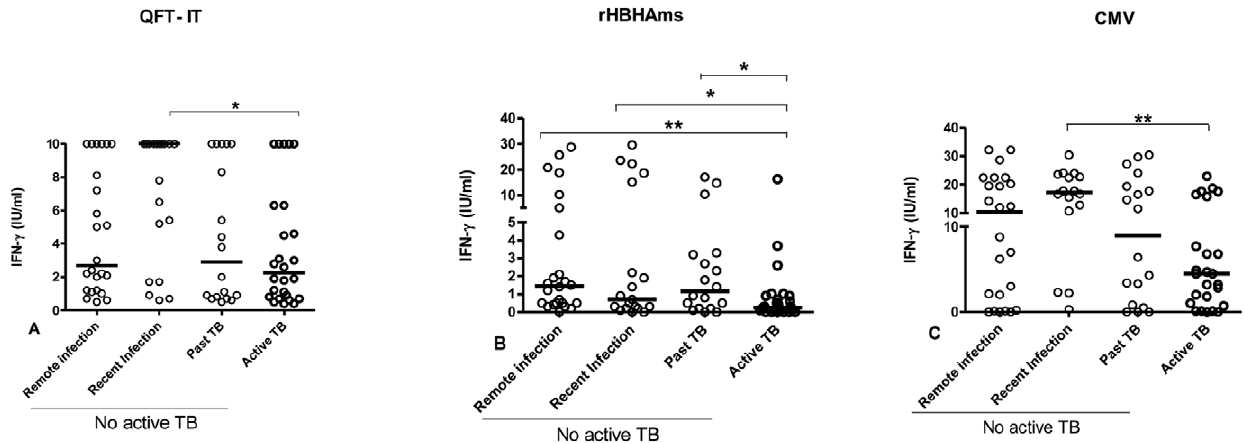
Figure 2. Response to rHBHAms is significantly impaired in patients with active TB. Whole blood was stimulated with or without QFT-IT ( A ), rHBHAms ( B ) and CMV lysate ( C ). IFN- c response was evaluated after a short-term stimulation (1 day post- in vitro stimulation). The data are shown after the subtraction of the results obtained in the unstimulated sample. A significant difference in terms of IFN- c release to QFT-IT ( A ) and CMV lysate ( C ) was found between those with active TB and recent infection (p=0.01 and p=0.002 respectively). A significant lower response to rHBHAms ( B ) was found in patients with active TB compared to those with remote LTBI (p=0.001) and past TB (p=0.02).